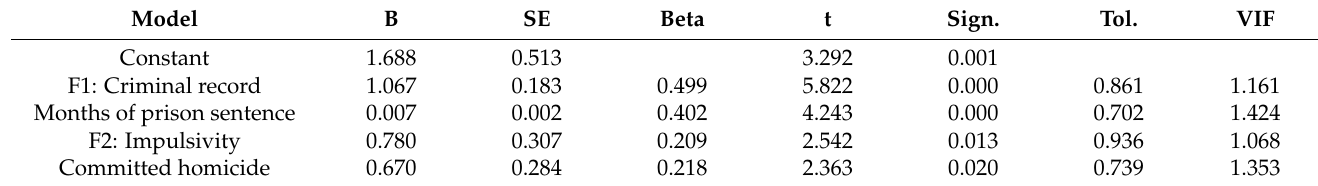
Table 4. Linear regression indices with Factorial Confirmatory Analysis